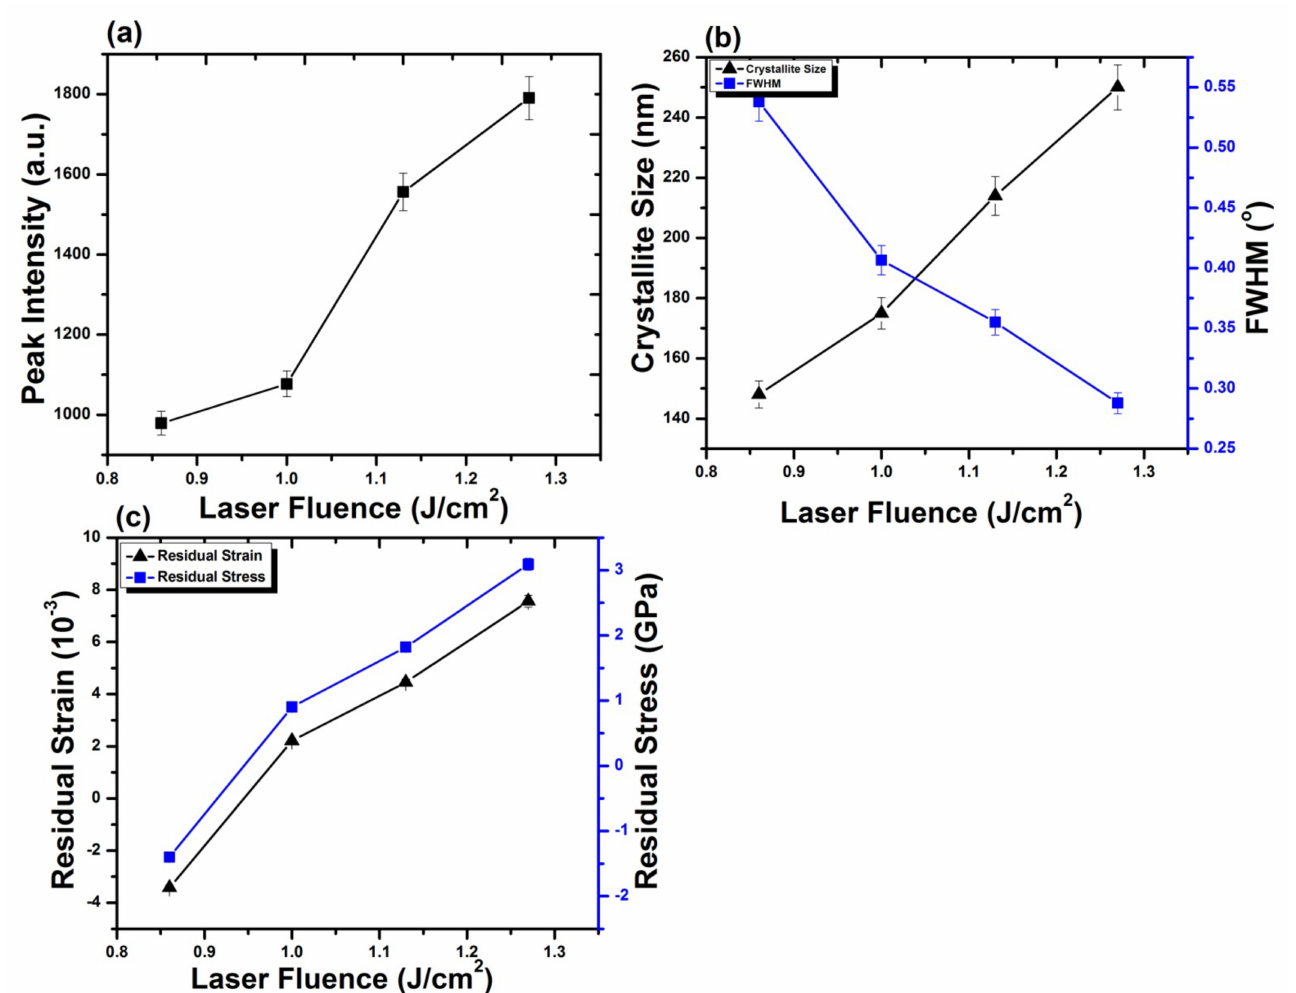
Figure 10. ( a ) The variation in peak intensity for Al 2 O 3 (202) orientation plane with variation of laser fluence from 0.86 to 1.27 J · cm − 2 , under O 2 ambient for 100 laser pulses at pressure of 100 torr. ( b ) The variation in crystallite size, FWHM and ( c ) relation between residual strain and residual stress with variation of laser